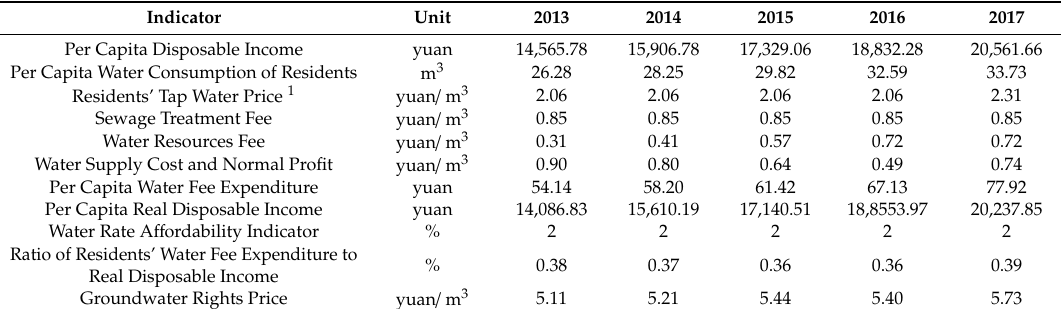
Table 6. Indicators of groundwater rights